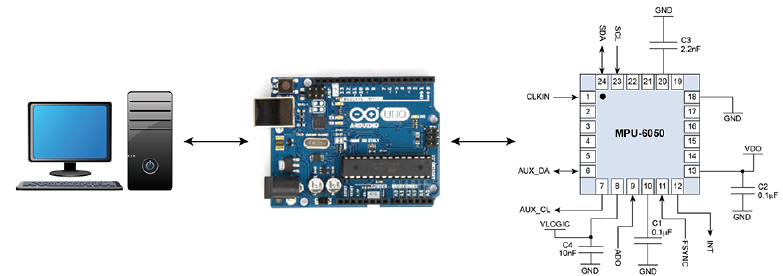
Figure 2. Schematic of the experiment.